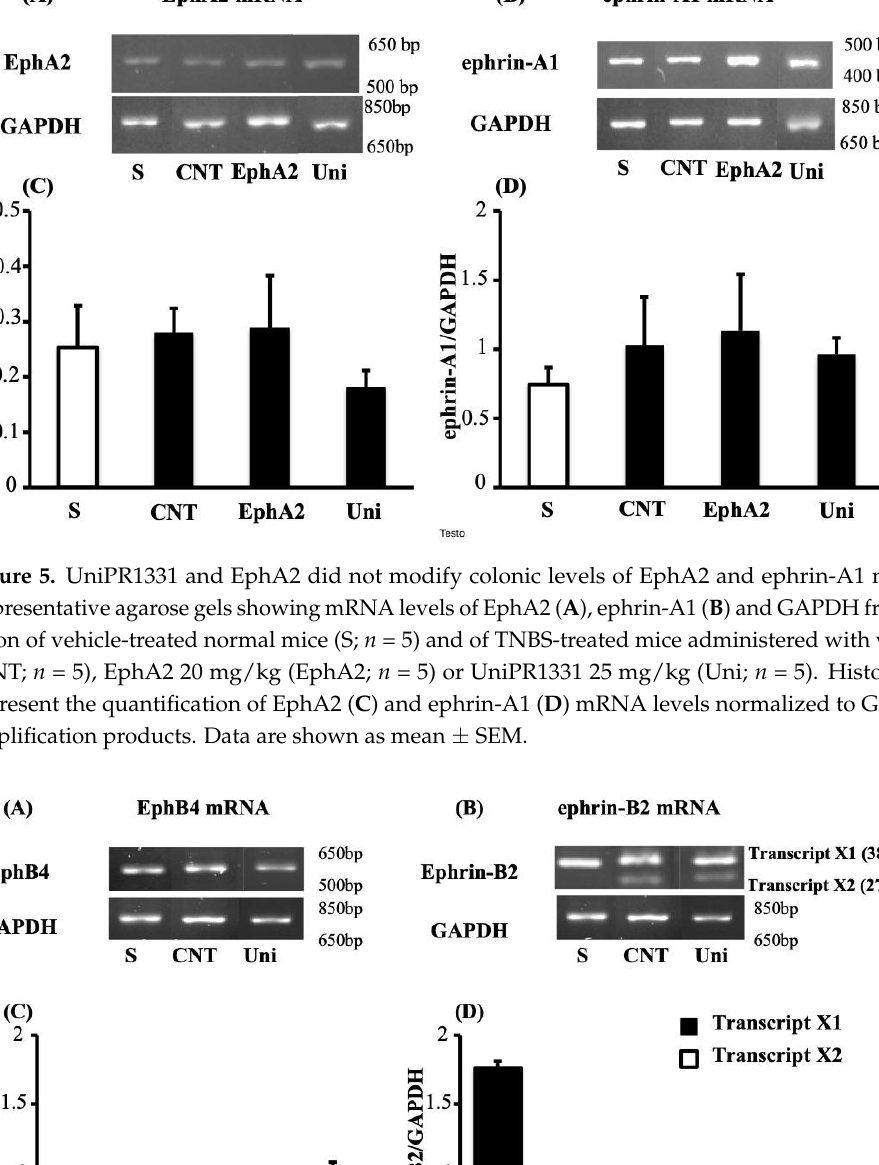
Figure 6. UniPR1331 did not modify colonic levels of EphB4 and ephrin-B2 mRNA. Representative agarose gels showing mRNA levels of EphB4 ( A ), ephrin-B2 ( B ) and GAPDH from the colon of vehicle-treated normal mice (S; n = 7) and of TNBS-treated mice administered with vehicle (CNT; n = 4) or UniPR1331 25 mg/kg (Uni; n = 5). Histograms represent the quantification of mRNA levels of EphB4 ( C ) and of transcripts X1 (black bars) and X2 (white bars), encoded by ephrin-B2 gene ( D ), normalized to GAPDH amplification products. Data are shown as mean ± SEM. * p < 0.05 vs. S mice, one-way ANOVA followed by Bonferroni’s